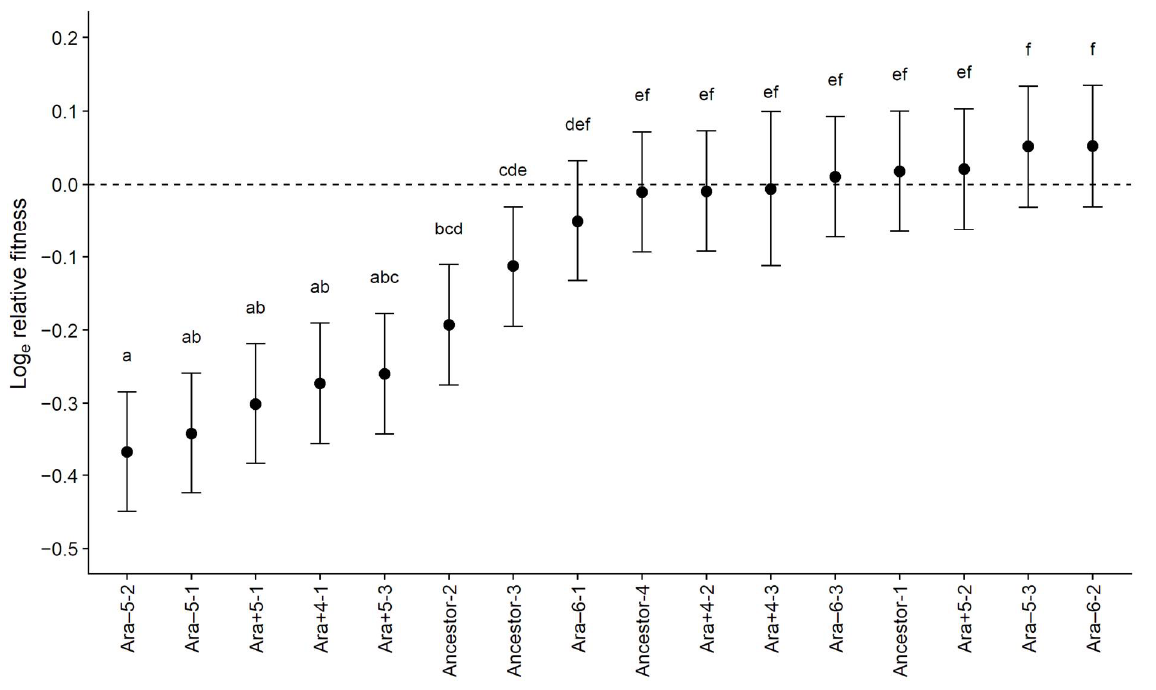
Figure 1. Fitness of 16 ampicillin-resistant mutants, each relative to its parental strain. The mutants are arranged from lowest to highest fitness. Each symbol shows the mean log e -transformed fitness based on five-fold replication of paired assays. Error bars show 95% confidence limits calculated using the t -distribution with 4 d.f. and the pooled standard deviation from the ANOVA (Table 1). Letters above the error bars identify sets of mutants with relative fitness values that do not differ significantly, based on Tukey’s “honest significant difference” test for multiple comparisons. The dashed line shows the expected relative fitness under the null hypothesis of no cost of resistance. Table 1. ANOVA on the log e -transformed fitness estimates of 16 ampicillin-resistant lines, each measured relative to its sensitive